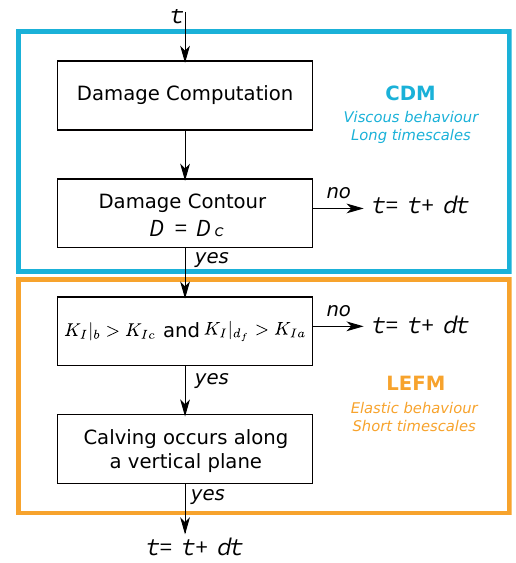
Figure 4. Algorithm of the calving model where t refers to the time step. The blue shape indicates the area of CDM application, where the ice is viscous, and the orange shape corresponds to the LEFM domain of application, where the ice is elastic, representing fracture propagation and calving